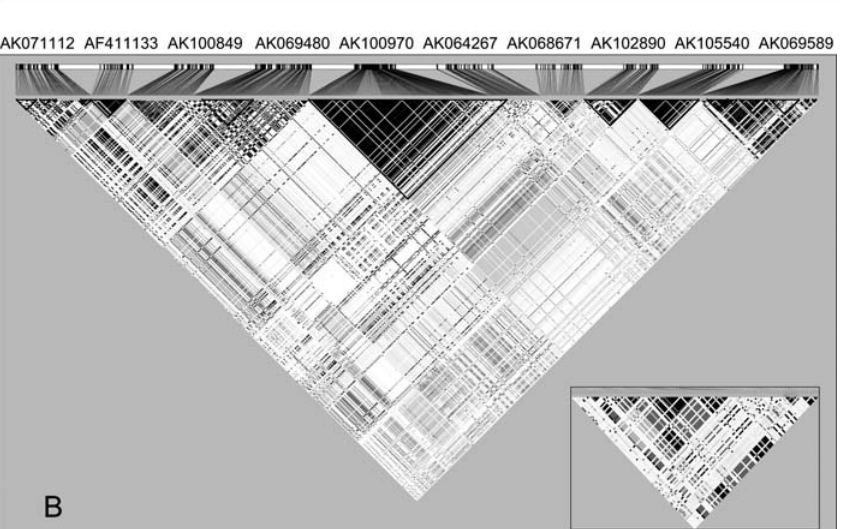
Figure 2. LD Patterns for High Polymorphism and Reference Genes LD are shown by the r 2 statistic, with white for r 2 ¼ 0, shades of gray for 0 , r 2 , 1, and black for r 2 ¼ 1. Genes are arranged by chromosome as in Figure 1 and Table 1. The haplotype blocks are delineated by bold lines. (A) O. sativa. (B) O. rufipogon . In both panels, the main one is for high polymorphism genes and the inset is for the less polymorphic reference genes.